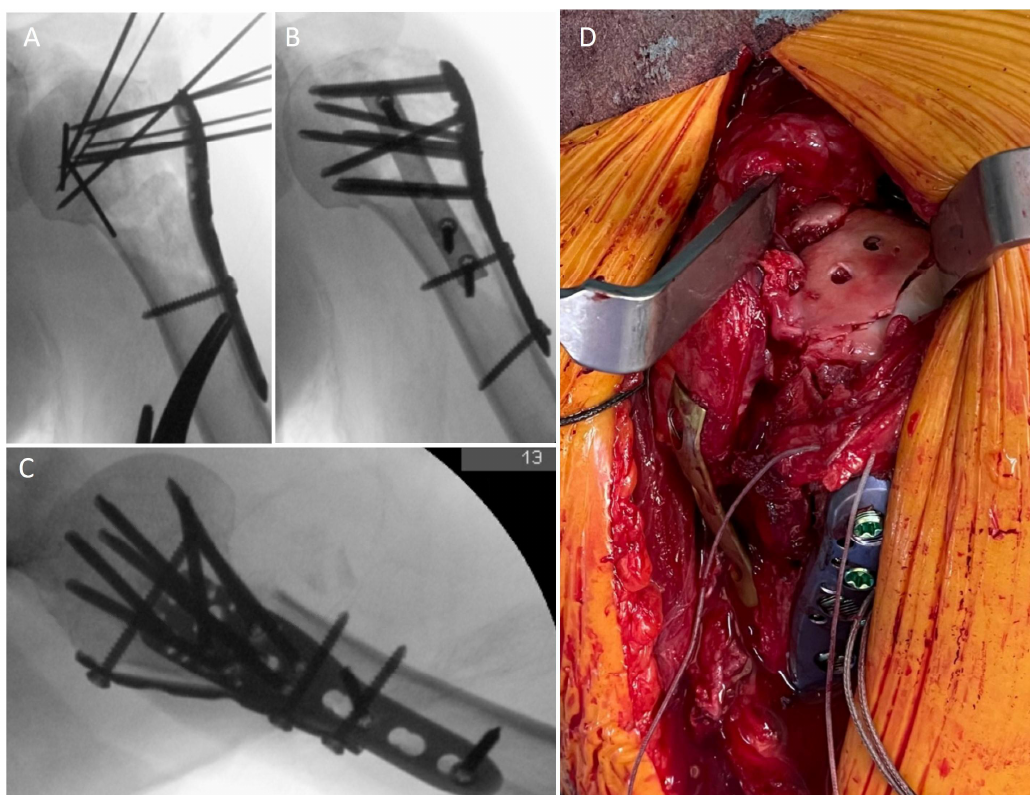
Figure 2. ( A – C ): Intraoperative X-rays demonstrating the reduction and fixation using the double plating technique of the patient in Figure 1. ( D ): Intraoperative clinical picture showing an opened-up rotator interval to control the reduction of the articular surface. The one-third tubular plate is placed on the lesser tuberosity.